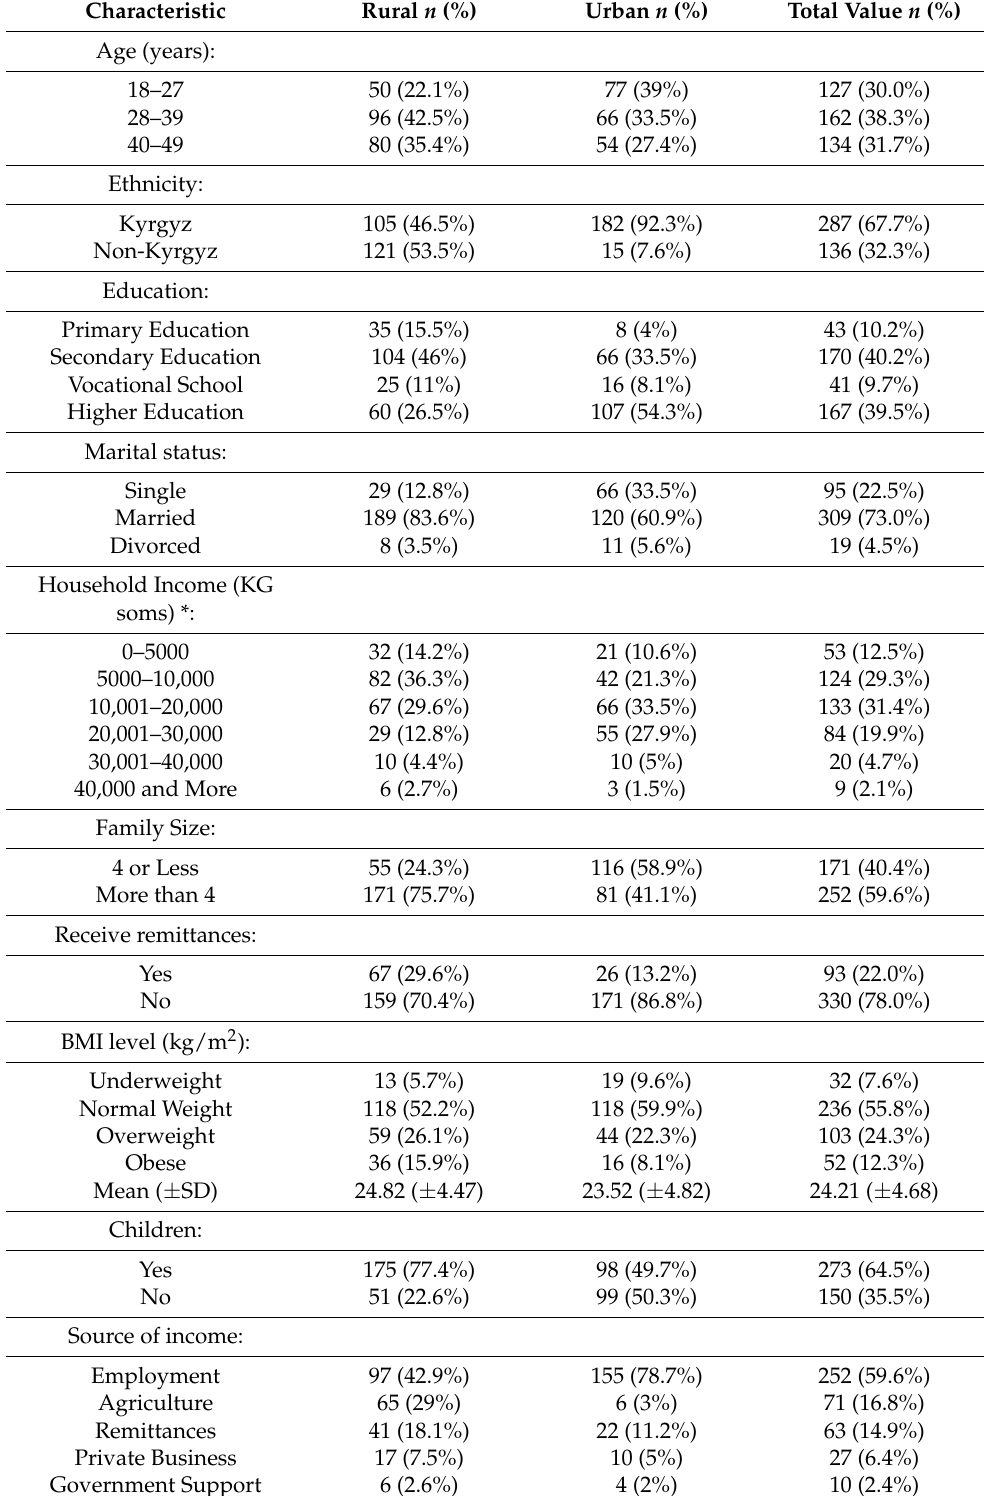
Table 2. Socioeconomic characteristics of respondents ( n =